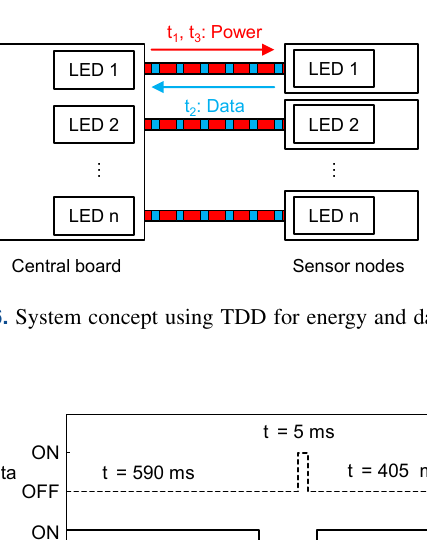
Figure 15. Eye pattern for 1Mbits − 1 PRBS data transmission with the two red LEDs as TX and RX over 1m standard POF.